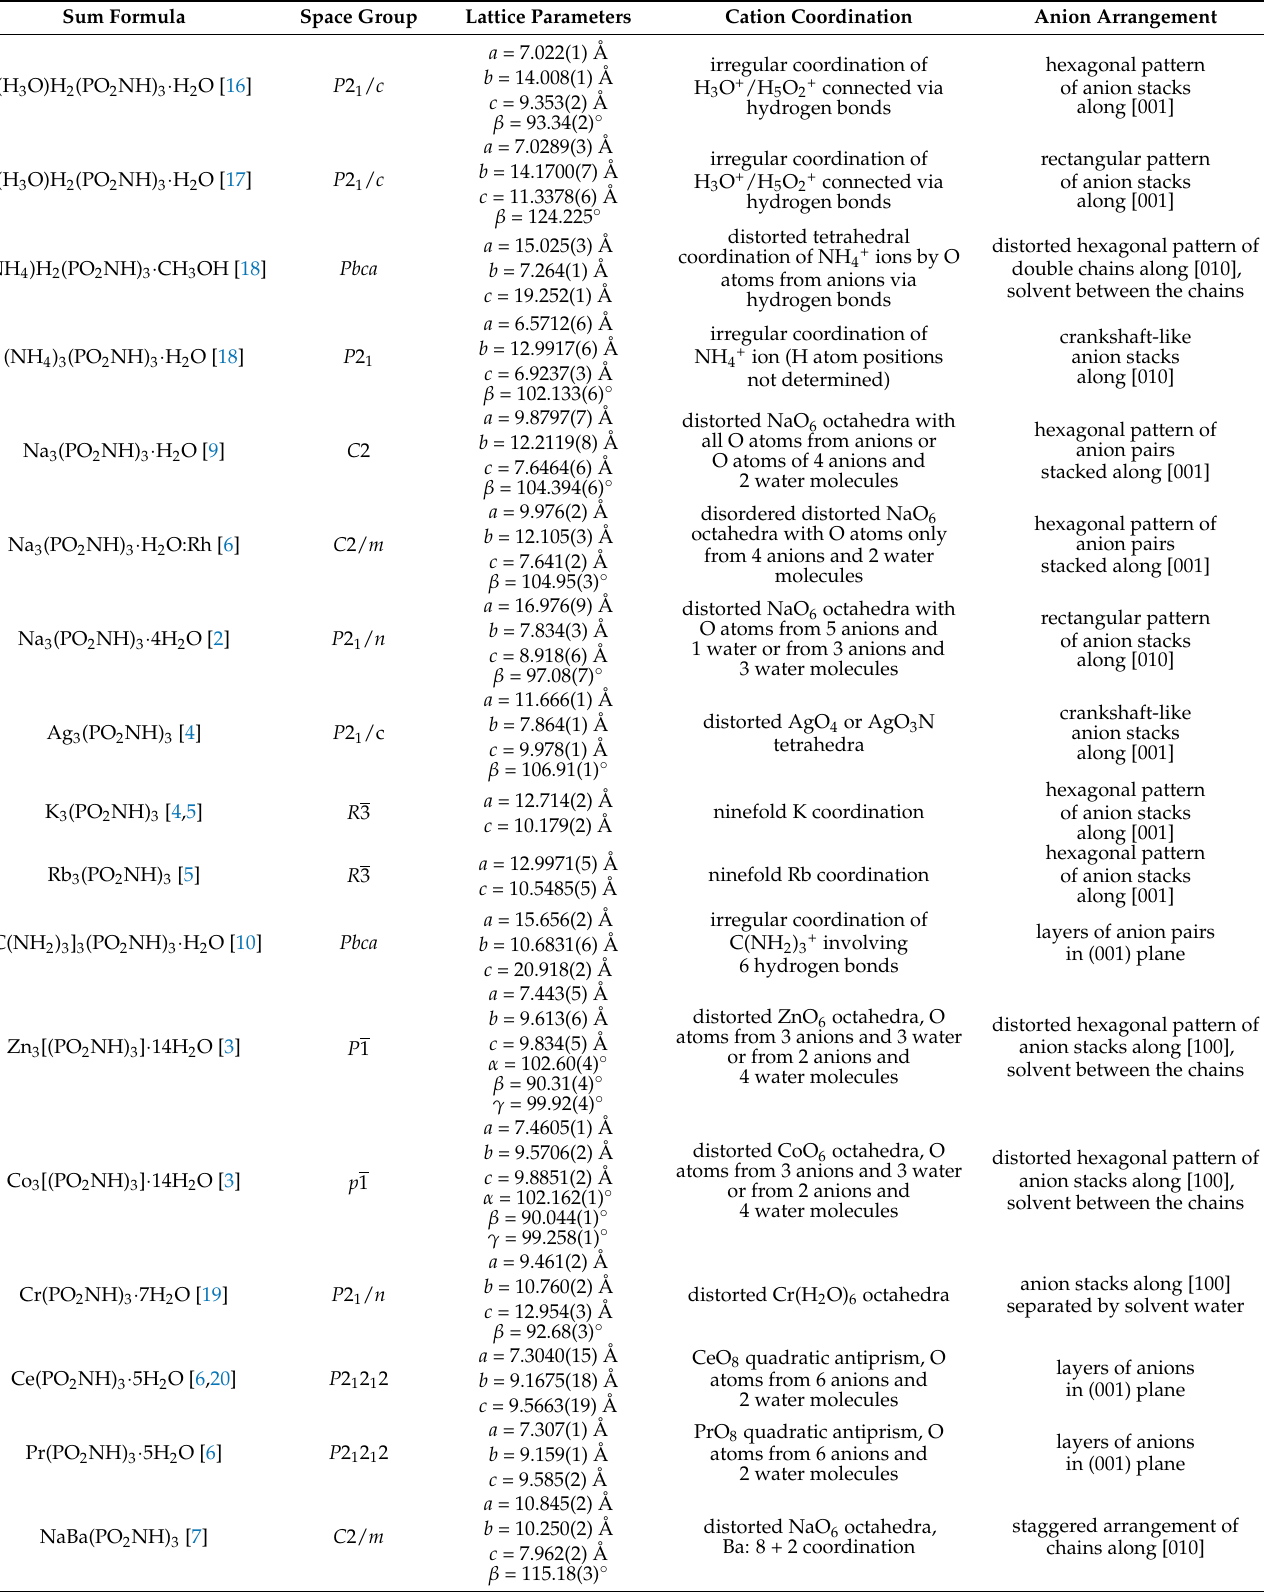
Table 1. A list of all crystal structure determinations of